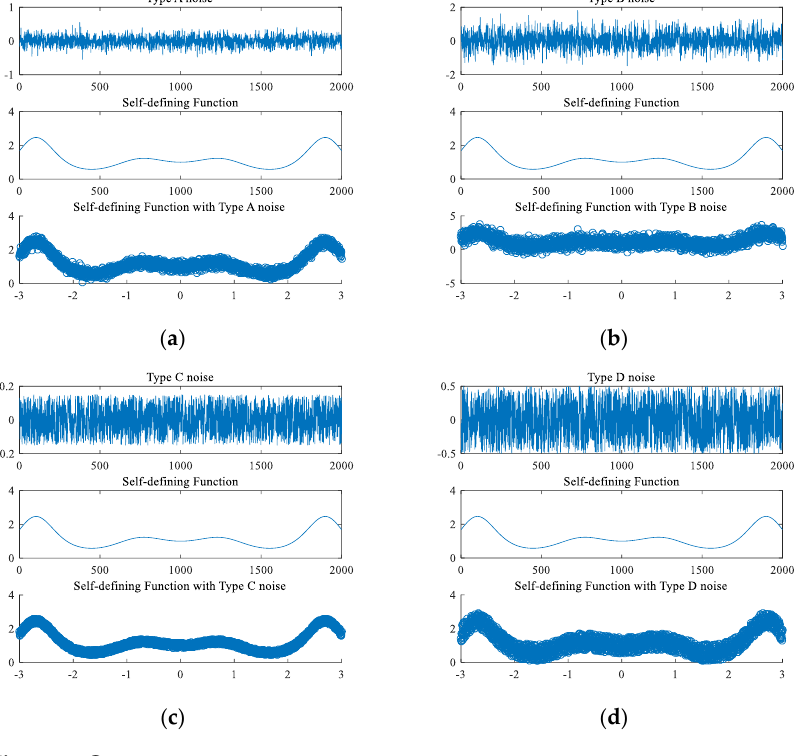
( f ) Figure 3. Graphs of the self-defining function with different noises. In our experiments, we randomly selected 1600 samples as the training dataset and the remaining 400 samples as the testing dataset. To evaluate the effectiveness of the pro- posed algorithm, we compared its performance to that of ELM, RELM, and CELM. Table 2 shows the optimal RMSE, MAE, SSE/SST, and SSR/SST of the four algorithms that were obtained based on the optimal parameters selected using the ten-fold cross-validation method. Table 2 also lists the optimal parameters for each algorithm. The regression fitting results of ELM, RELM, CELM, and L 1 -ACELM on two artificial datasets with noise are shown in Figures 4 and 5 .